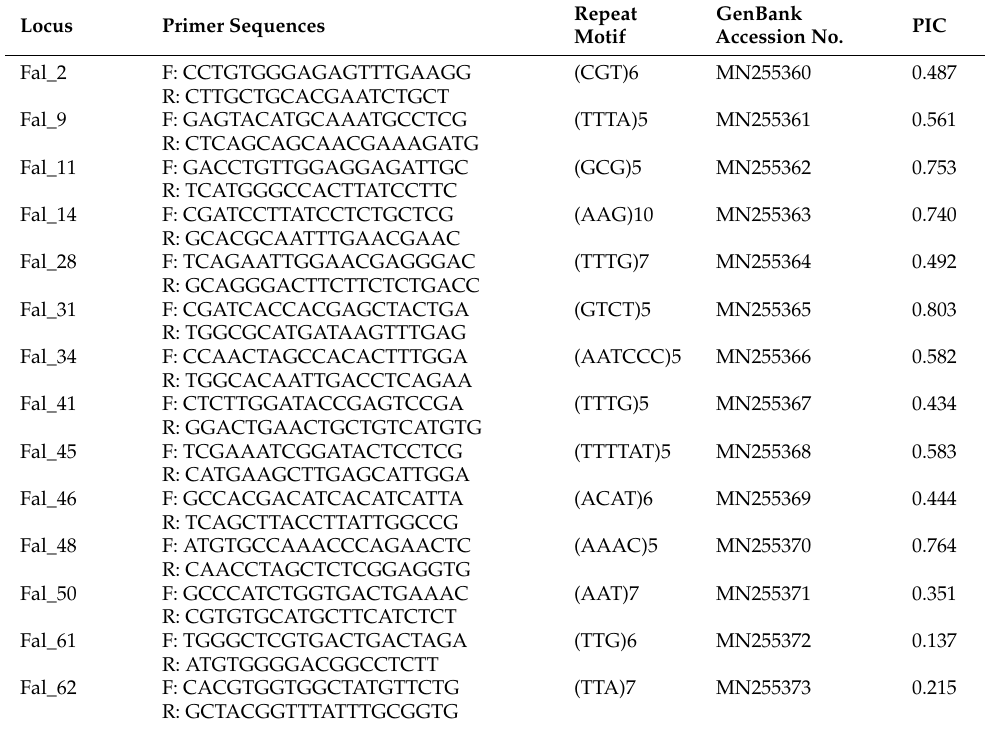
Table 1. Sixteen nSSRs developed for F. altissima